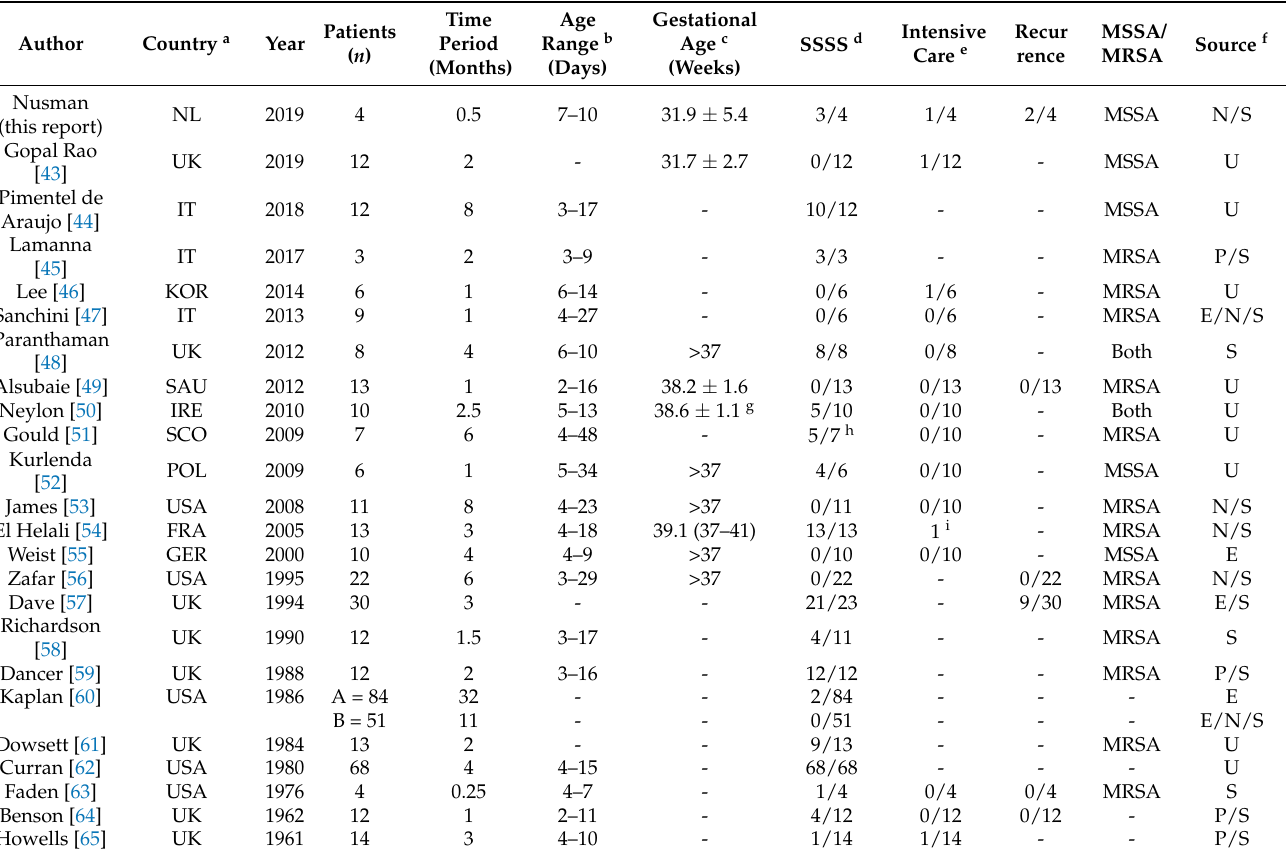
Table 1. Host characteristics in the overview of reported outbreaks ( n = 23) on neonatal skin infections by S. aureus